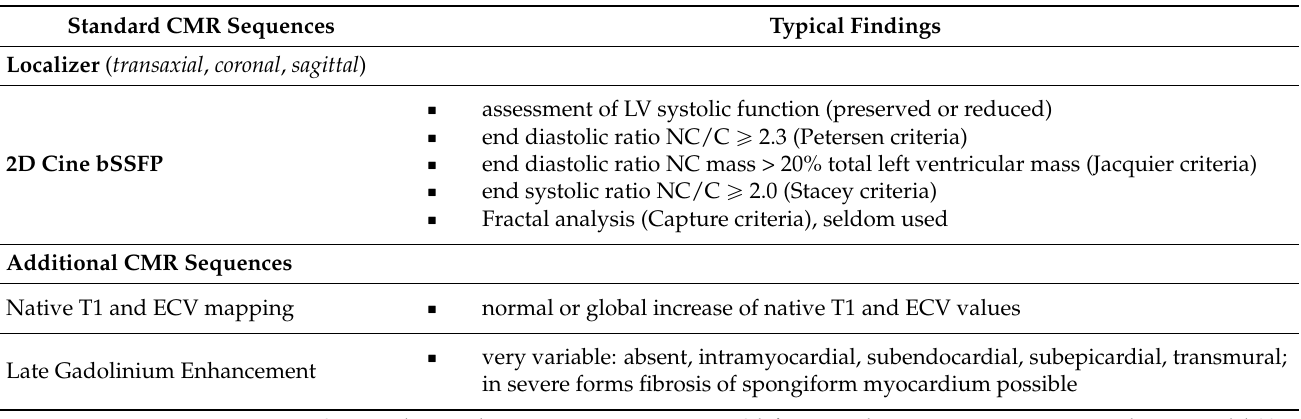
Table 3. Standard and additional CMR sequences for assessment of LVNC in